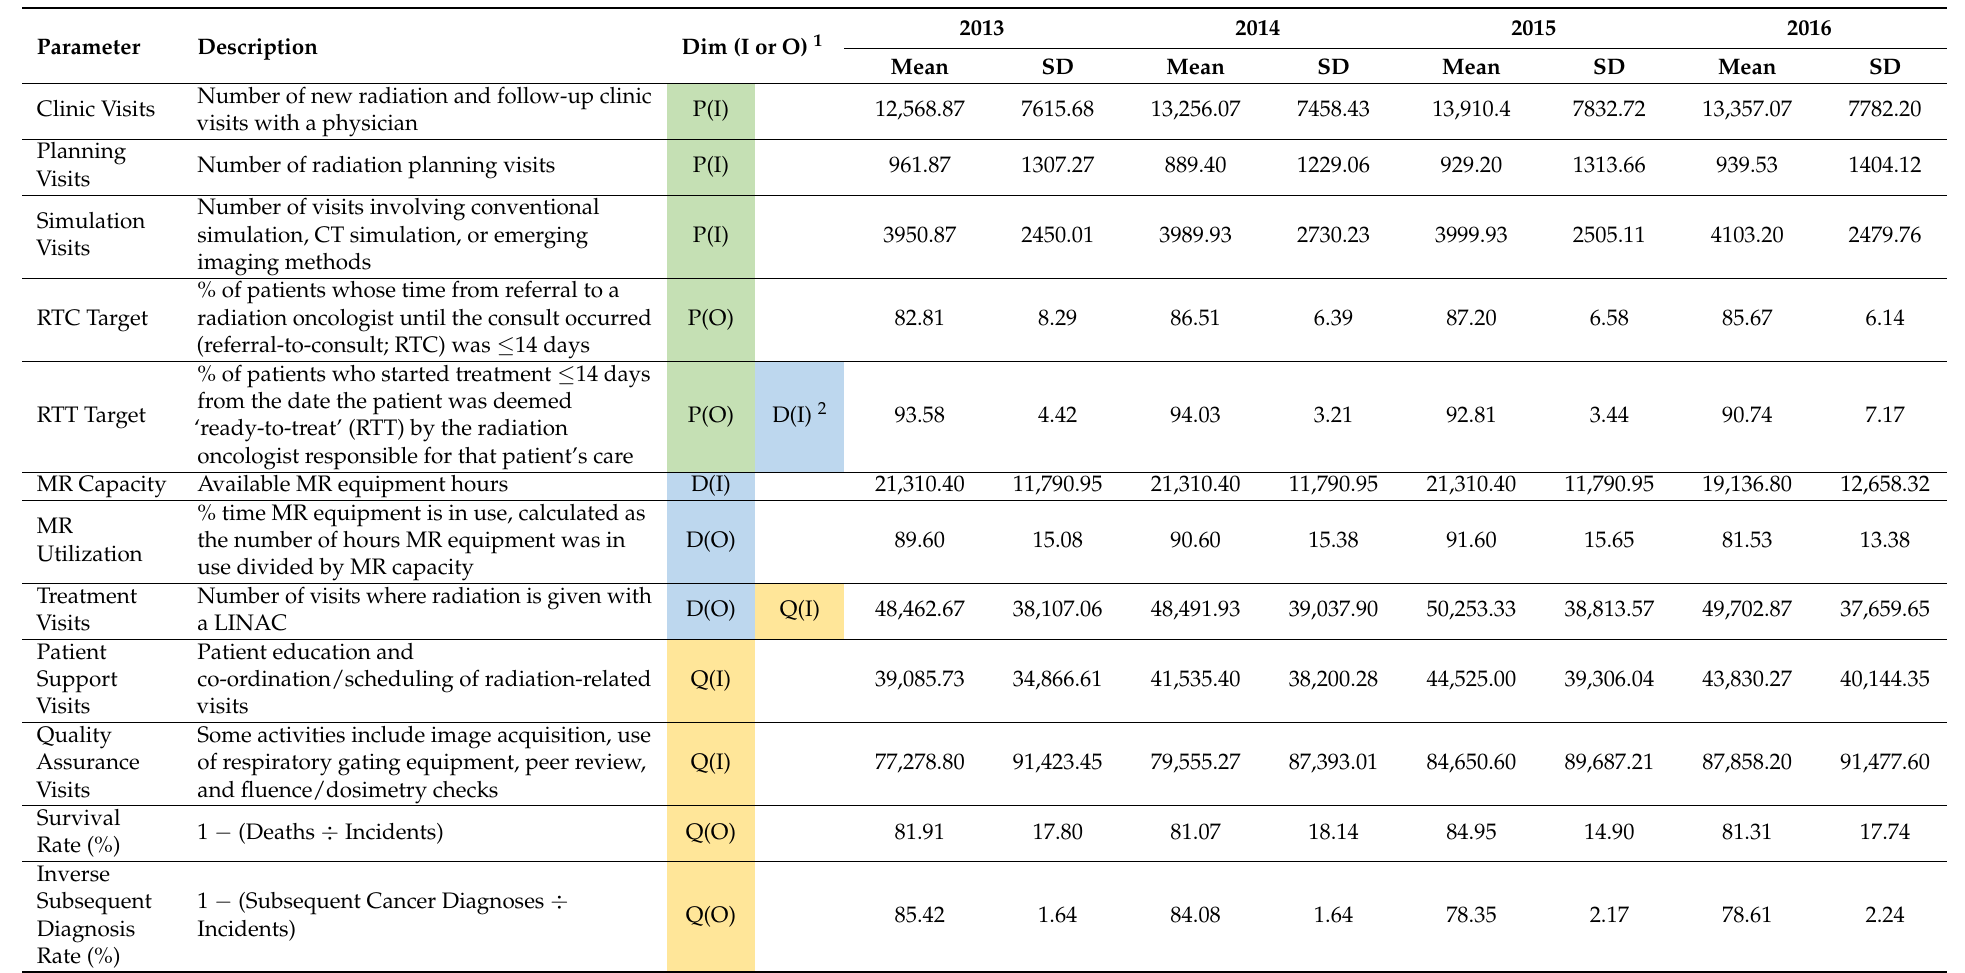
Table 2. Input and output parameters for DEA